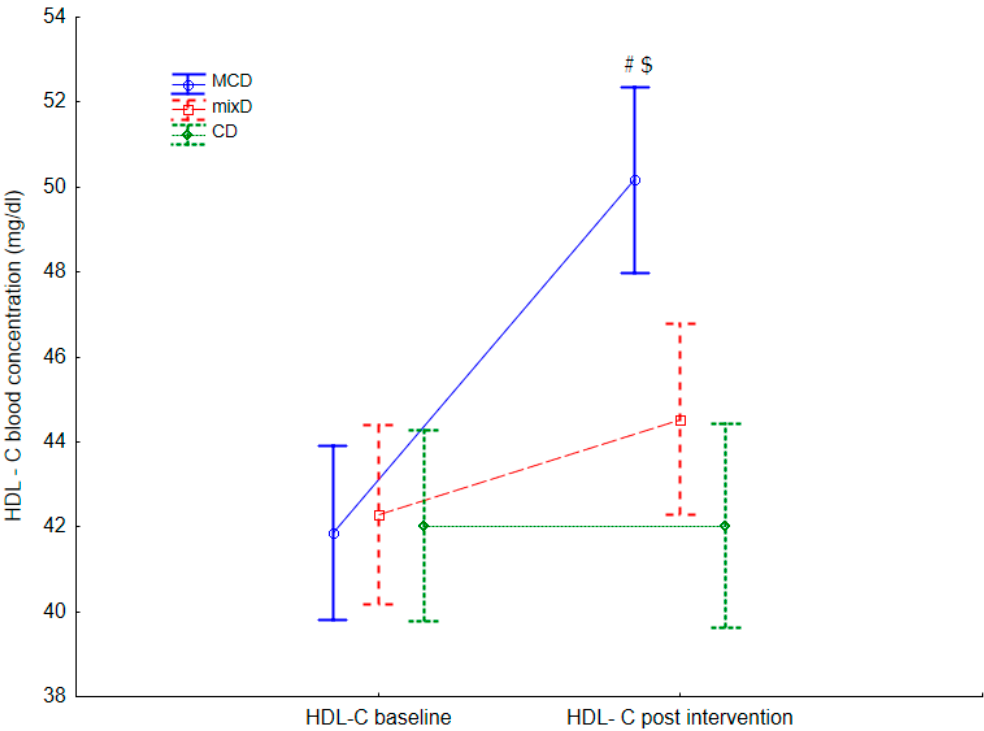
Figure 2. Differences in HDL-C postintervention between the moderate-carbohydrate diet (MCD). Values are expressed as mean and standard deviation. Mix diet (MixD) and conventional diet (CD) groups; #—significant difference compared with base line, $—significant differences compared with the MixD and CD groups, respectively ( p < 0.05).